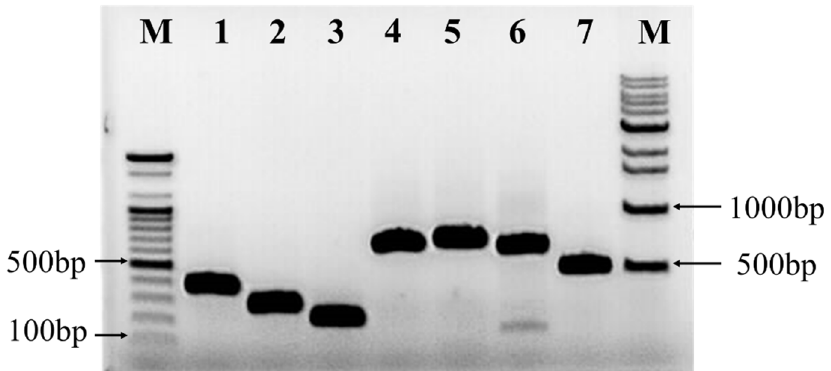
Figure 6. Agarose gel-electrophoresis of polymerase chain reaction fragments of antibiotic biosynthe- sis genes isolated from B. velezensis RDA1: Lane M, right side 100 bp and left side 1 kb DNA, Ladder from Bioneer; Lane 1, Bacillomycin gene bmyB ; Lane2, Fengycin gene fenD ; Lane 3, Surfactin gene srfAA ; Lane 4, Macrolactin gene mlnA ; Lane 5, Bacillaene gene baeA ; Lane 6, Difficidin gene done ; Lane 7, Bacilysin gene bacA